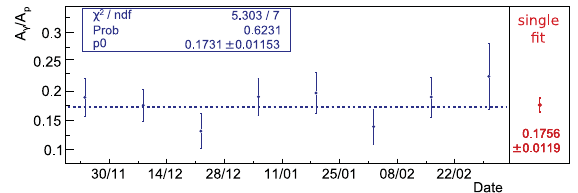
Figure 7. A γ / A p as a function of time for reactor turned off period and for one energy bin [2 . 675 − 3 . 125 MeV] in cell 4. Blue symbols are 14 days of data and the red symbol is integrated data over the whole reactor turned off period.